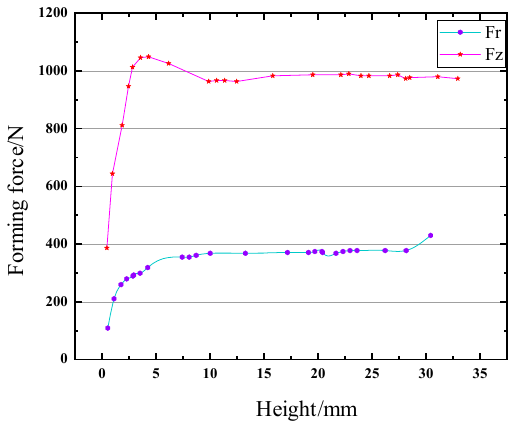
Figure 11. Radial and axial deformation forces of specimen 1.